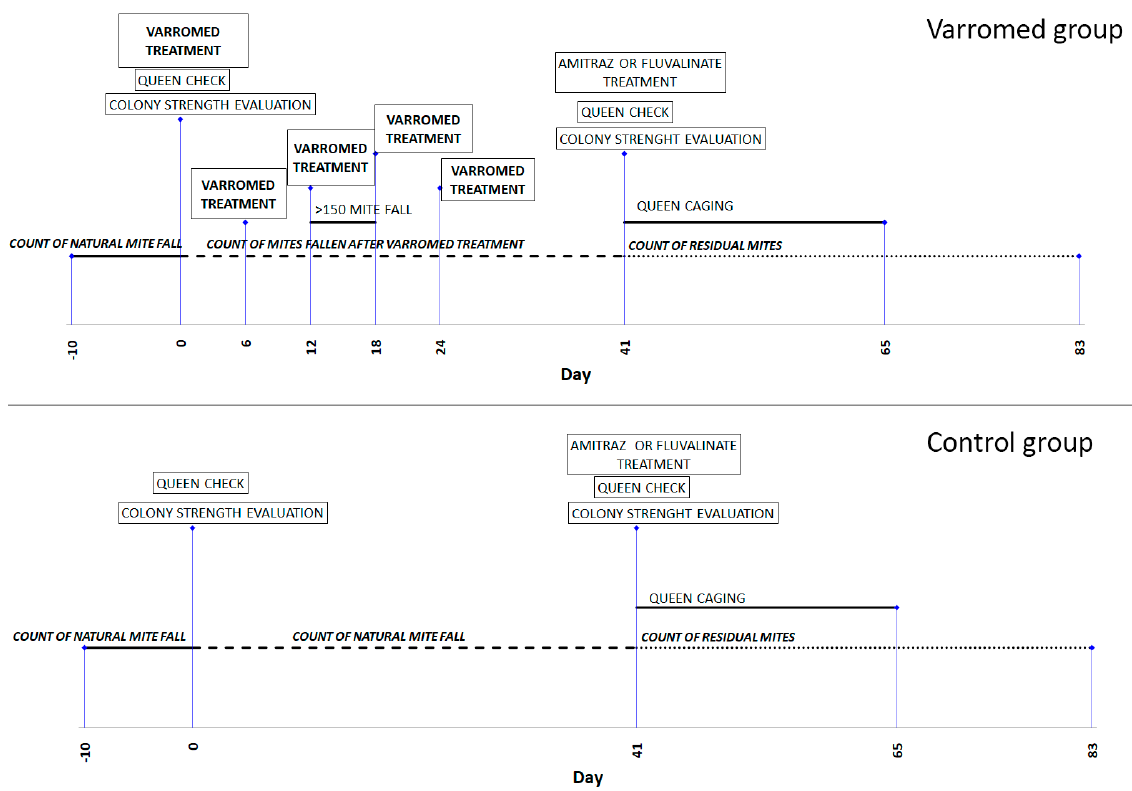
Figure 1. Summer/autumn protocol for the treated group (five repeated treatments) and control group. The following two treatments are additionally applied, if more than 150 mites are detected on the sticky boards within 6 days after the third treatment.